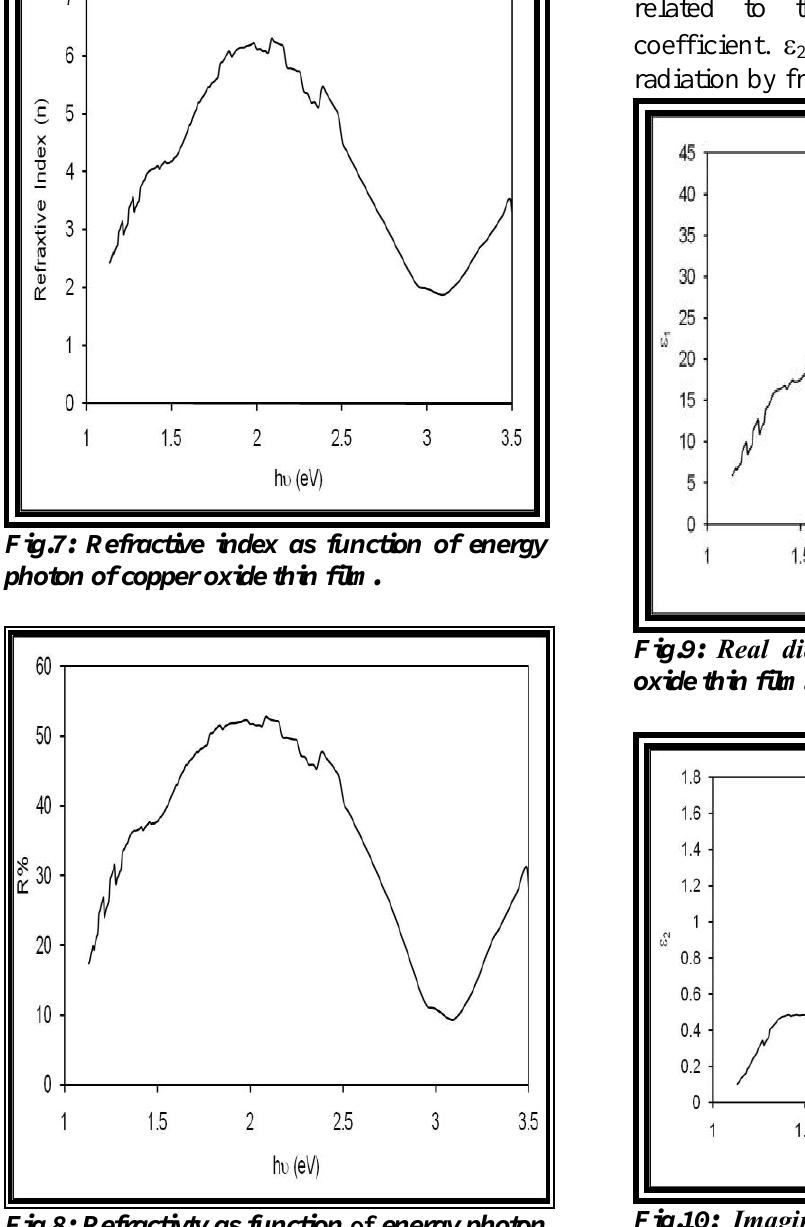
Fig.8: Refractivty as function of energy photon of copper oxide thin film.